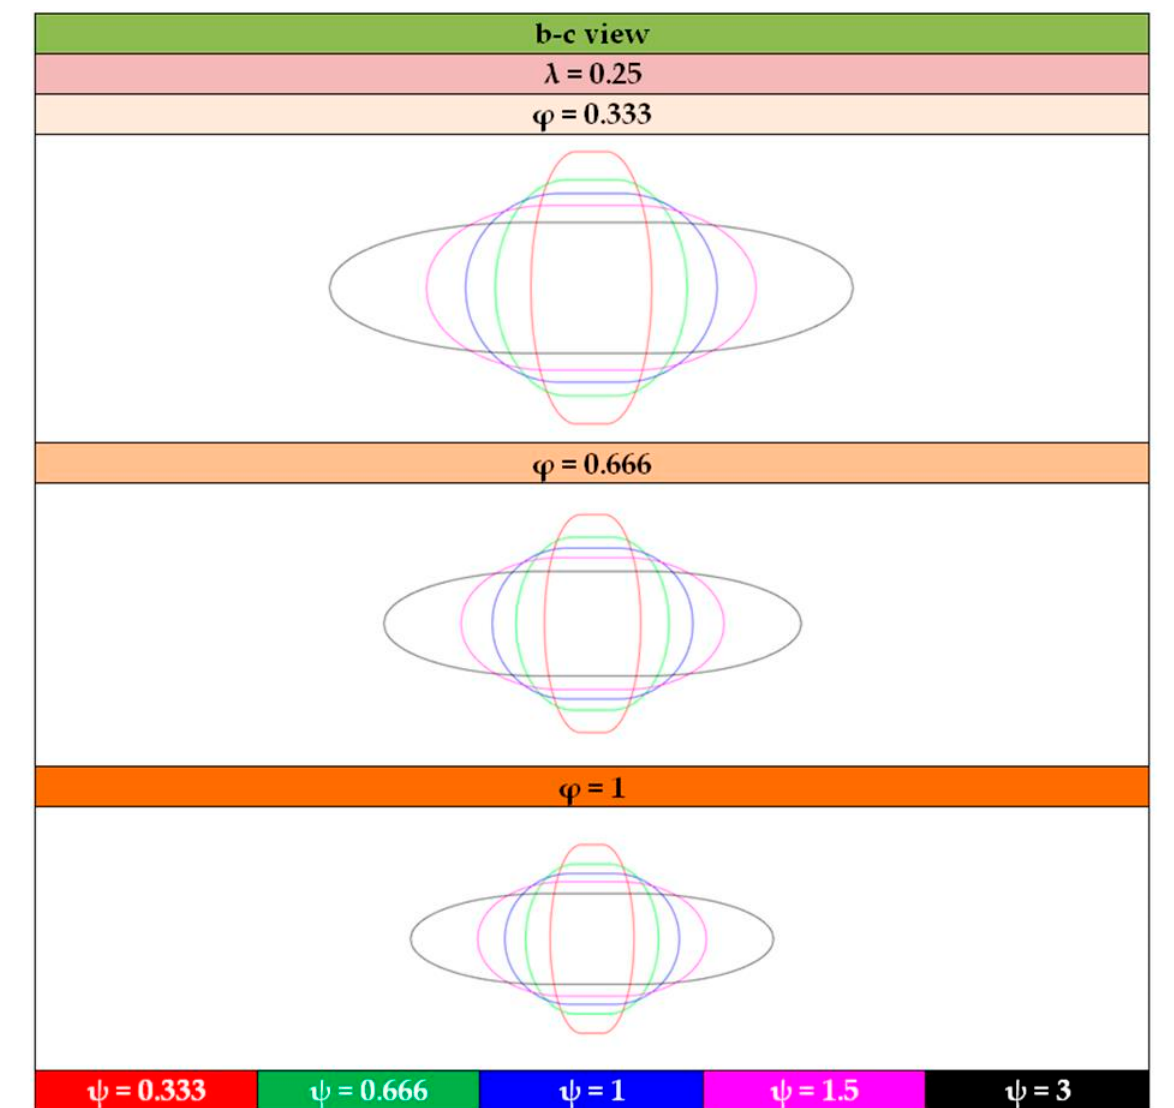
Figure 15. Graphical representation of the a–c view of tank configurations with λ = 0.25.